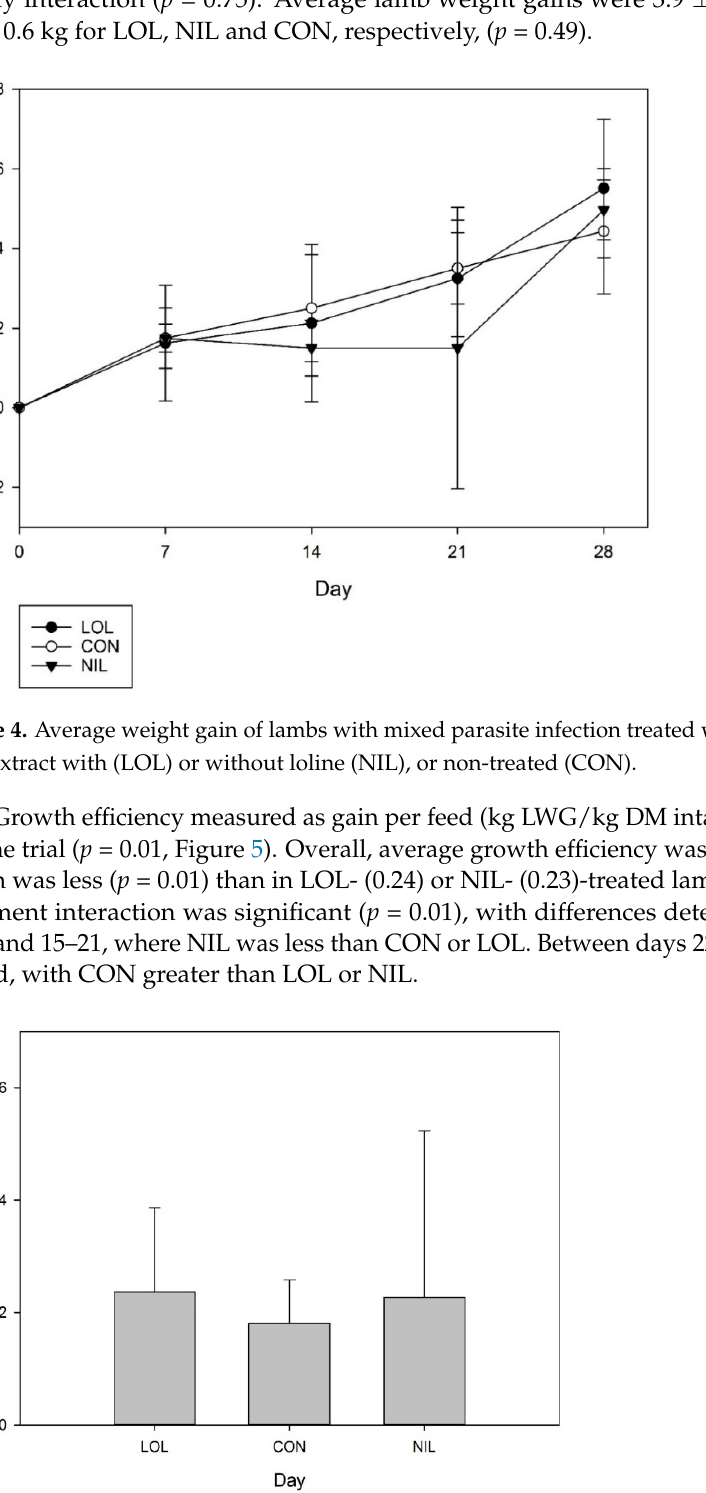
day interaction ( p = 0.75). Average lamb weight gains were 3.9 ± 0.6, 3.5 ± 0.5, and 2.8 ± 0.6 kg for LOL, NIL and CON, respectively, ( p = 0.49). kg for LOL, NIL and CON, respectively, ( p = 0.49).